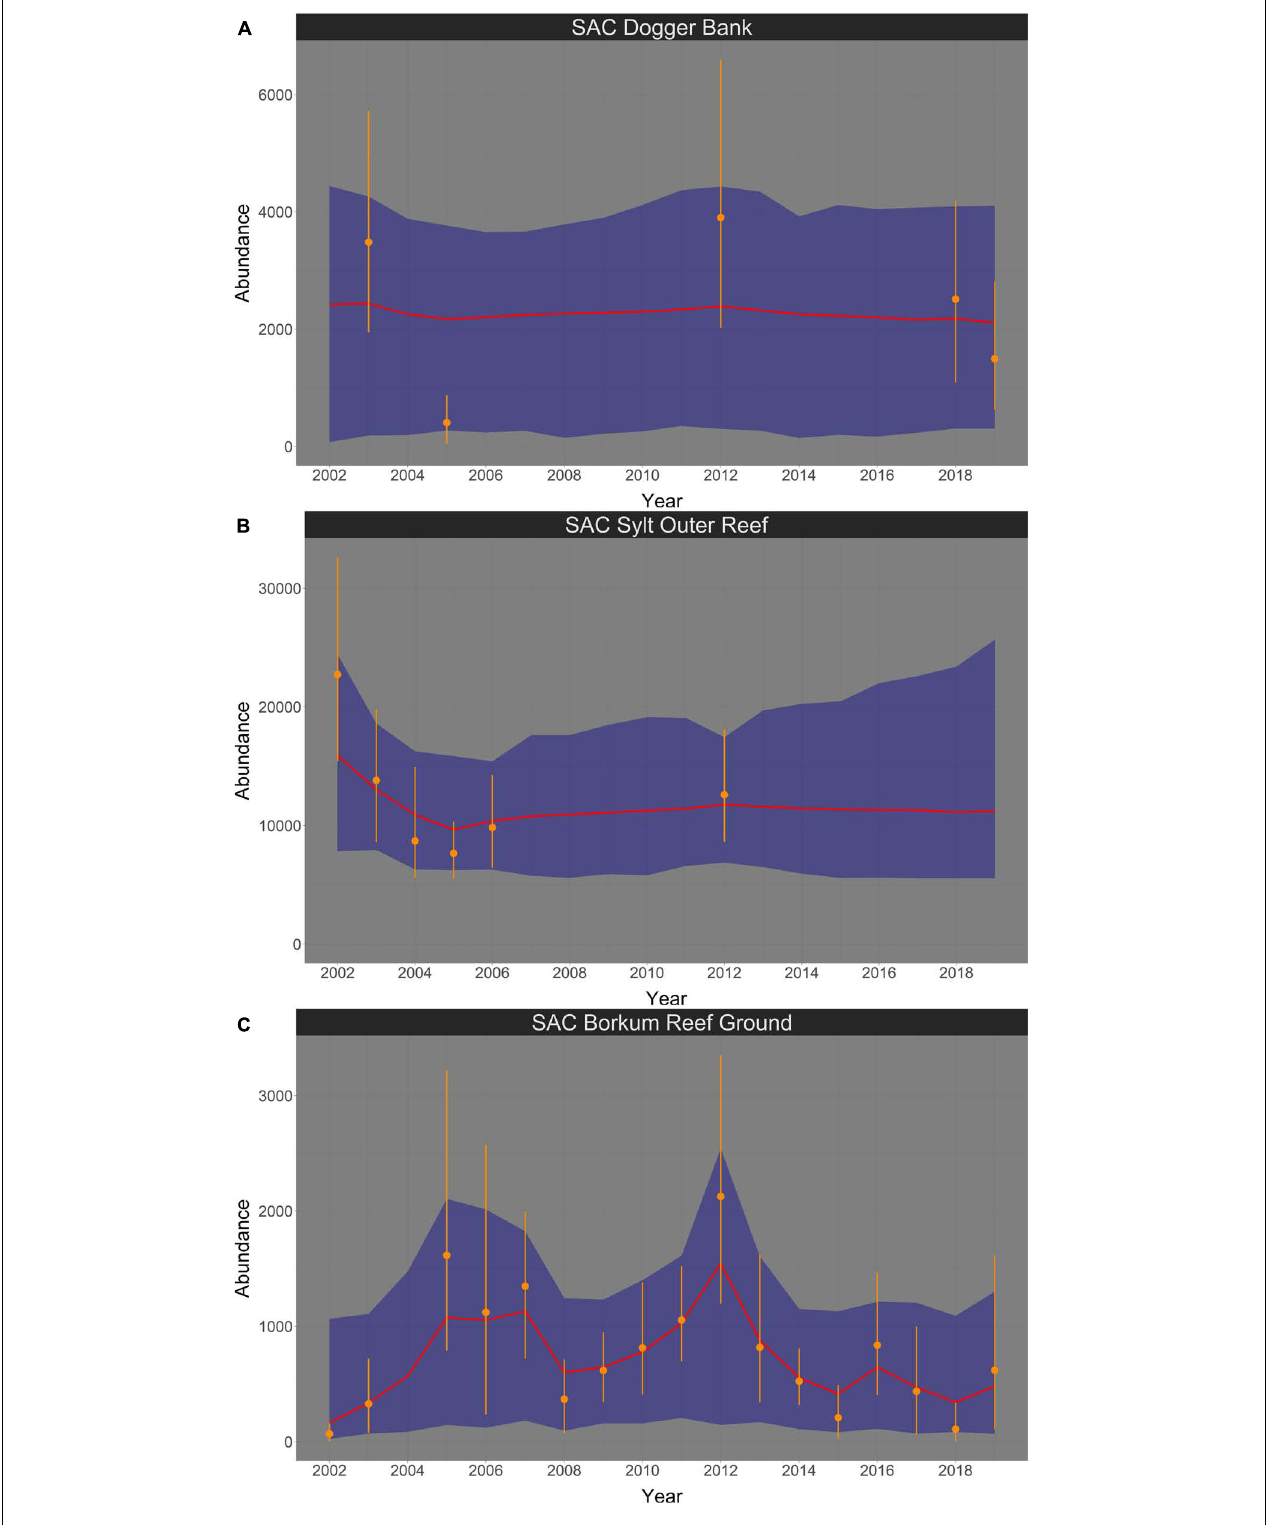
FIGURE 7 | Bayesian abundance trend analysis for harbour porpoises in the three SACs Dogger Bank (A) , Sylt Outer Reef (B) , and Borkum Reef Ground (C) , based on post-stratified aerial survey data in spring, between 2002 and 2019. Orange dots illustrate stratum-based abundance estimates and orange lines the associated 95% CI. The red line shows the median of the posteriori distribution of the calculated ‘true’ abundances from the Bayesian model, the blue shaded area displays the corresponding 95% credibility intervals. Please note in all figures the y-axis is free.